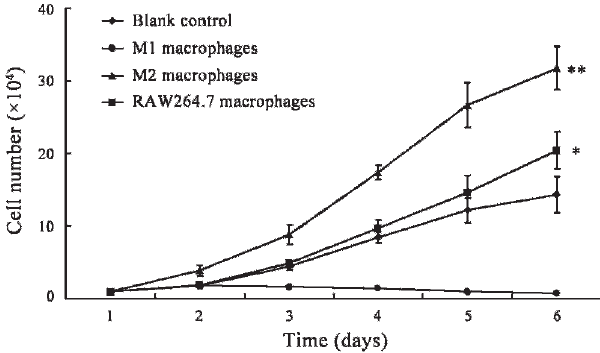
Figure 1 - Dynamic changes in LLC cell growth. Following culture of a blank control sample or co-culture with M1, M2, and RAW264.7 macrophages, the LLC cell number and viability were evaluated by trypan blue staining at the indicated times during a 6-day period. The data shown represent three experiments. * p , 0.05 and ** p , 0.01 compared to the blank control.